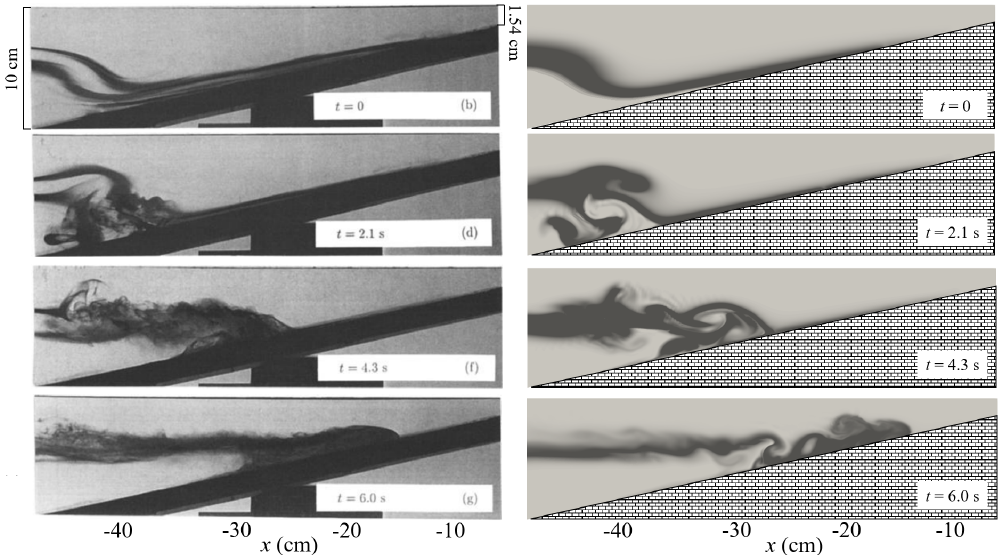
Figure 16. Comparison of the density fields between the experimental observation results in Michallet and Ivey (1999) (left) and the numer- ical simulation results (right).